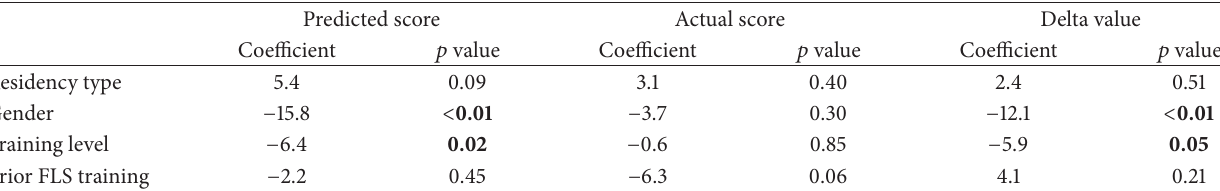
Table 5: Multivariate